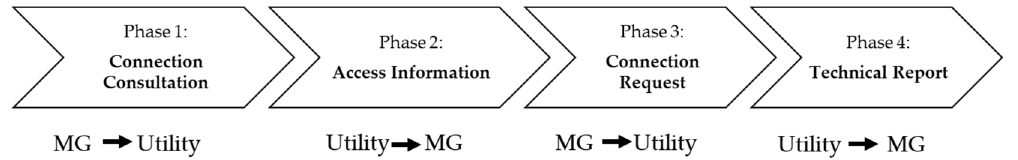
Figure 10. MGs connection to distribution grid procedure.